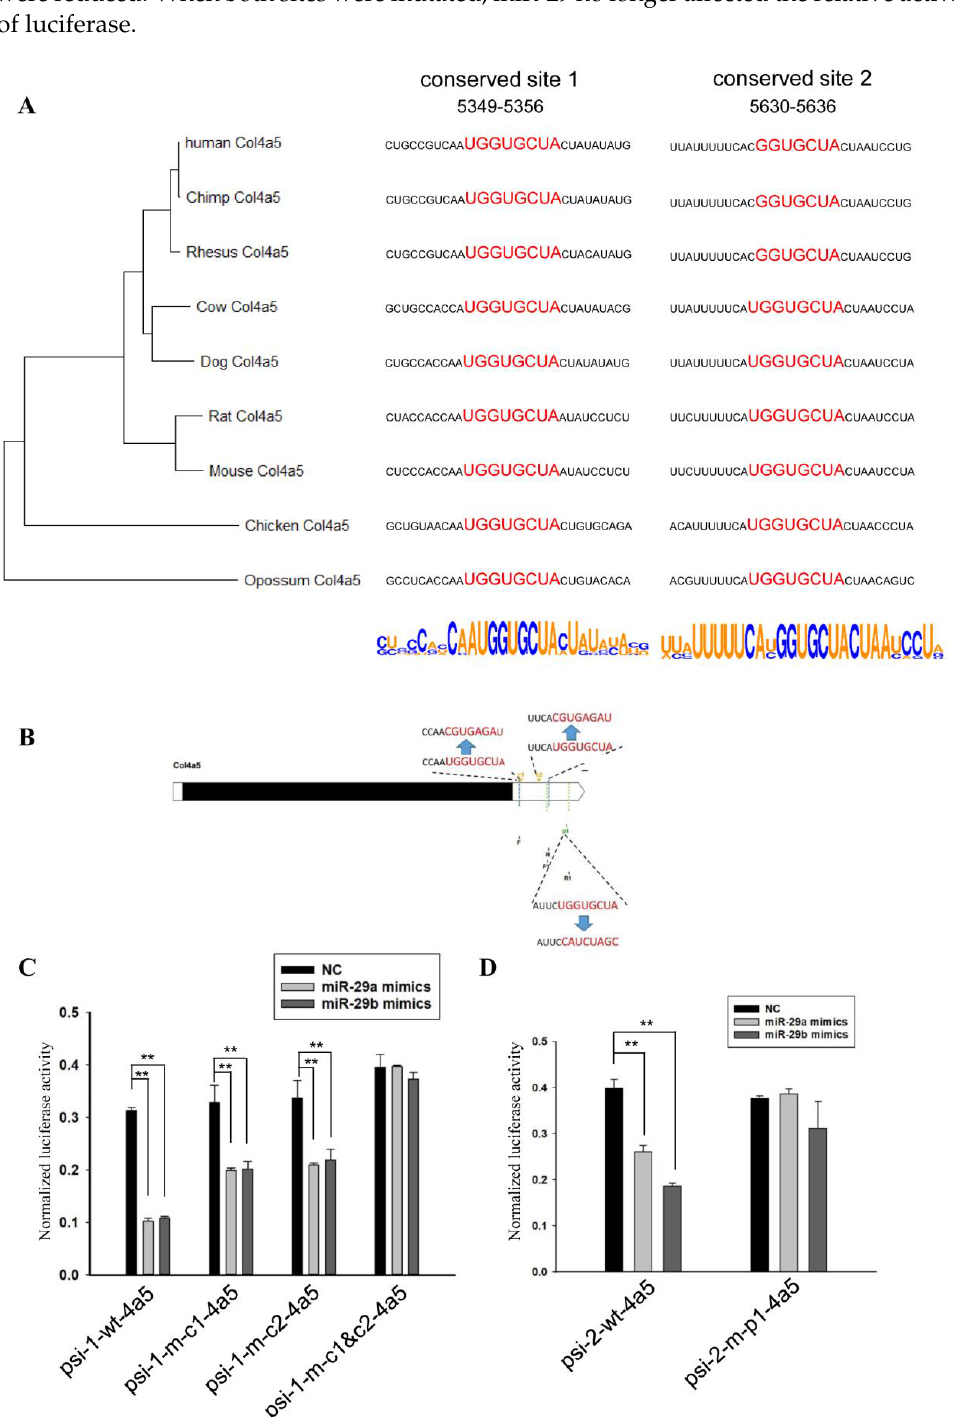
Figure 5. MiR-29 directly regulates the 3 ’ UTR of Col4a5 . ( A ) Phylogenetic tree constructed from the 3 ’ UTRs of Col4a5 in multiple species. Analysis of miR-29 binding sites and flanking sequences in the 3 ’ UTRs of Col4a5 in multiple species. ( B ) Schematic diagram of complementary sequence sites and primer sites. ( C ) The effect of miR-29a or miR-29b mimics on the relative luciferase activity of the psi-1-wt-4a5 vector, psi-1-m-c1-4a5 vector, psi-1-m-c2-4a5 vector, and the psi-1-m-c1&c2-4a5 vector was examined. The data are shown as the mean ± SEM ( n = 3). **, p < 0.01. ( D ) The effect of miR-29a or miR-29b mimics on the relative luciferase activity of the psi-2-wt-4a5 vector and psi-2-m-p1-4a5 vector was examined. The data are shown as the mean ± SEM ( n = 3). **, p <